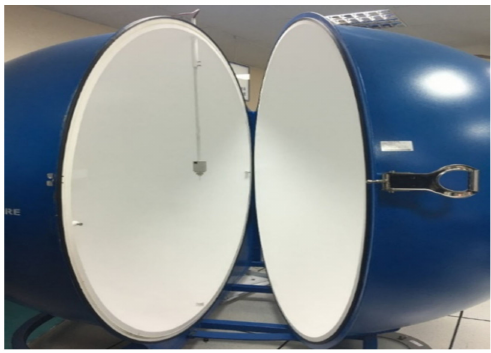
Figure 3. Integrating